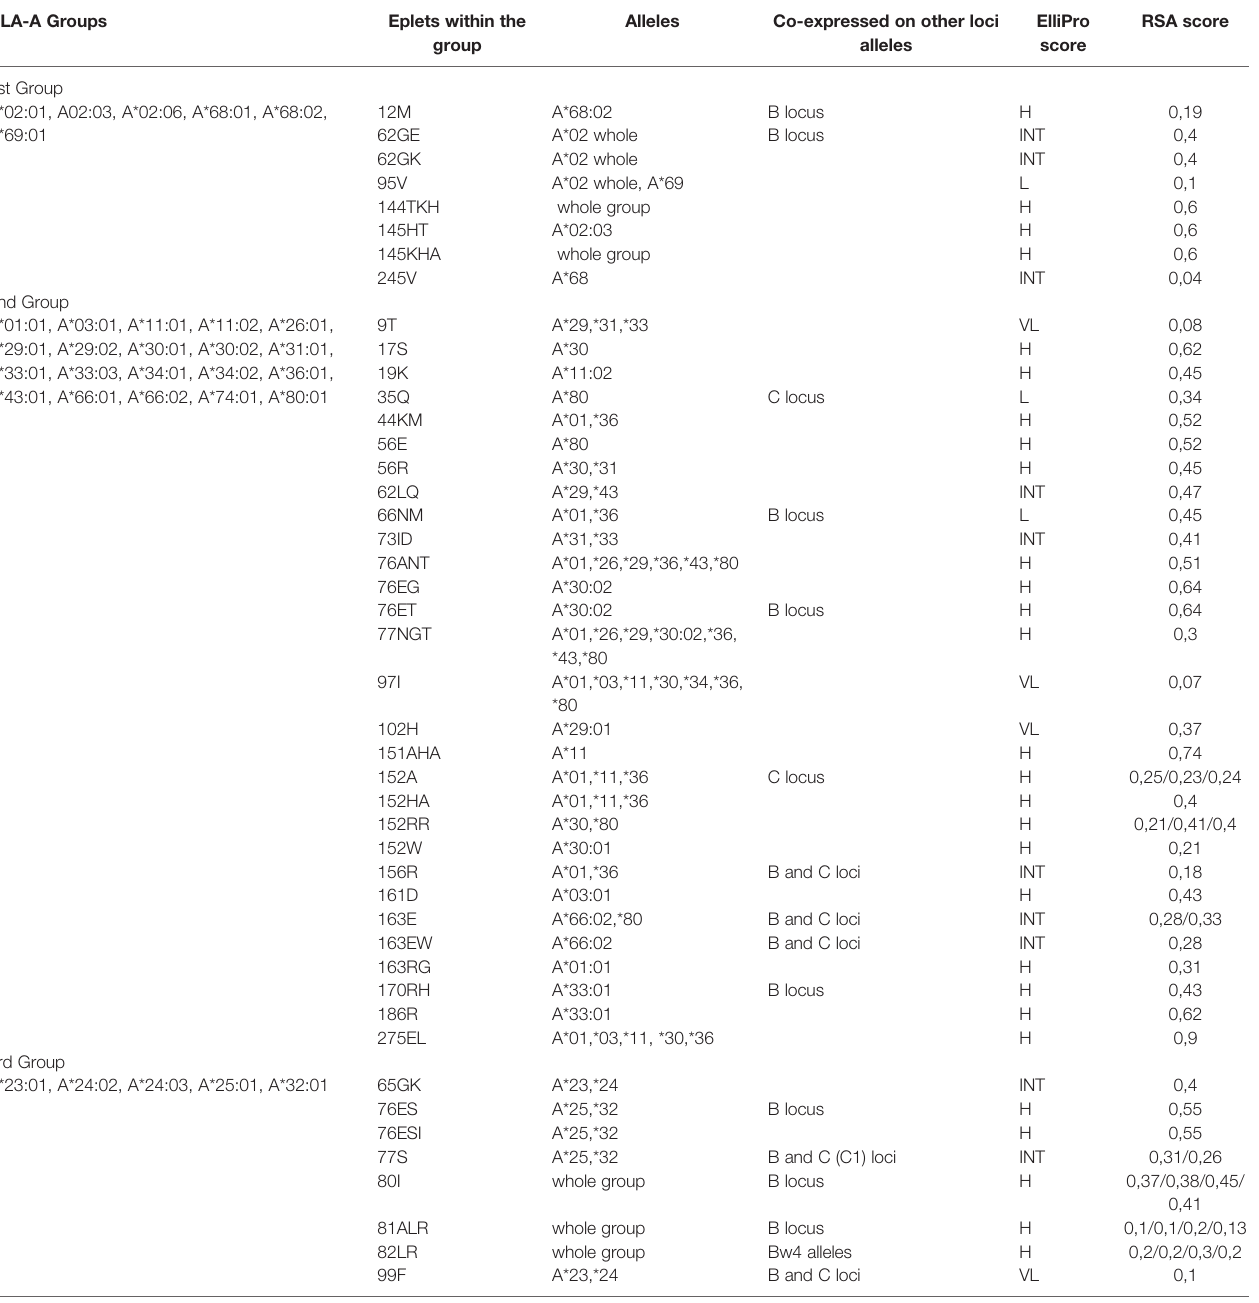
TABLE 1 | Antibody veri fi ed eplets for the three PCA de fi ned HLA-A groups with the one lambda bead array assay. HLA-A Groups Eplets within the